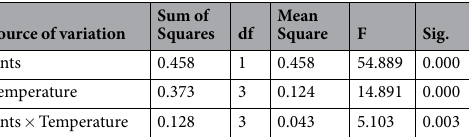
Table 2. Analysis of variance of the percentage parasitism with ant tending and temperature.